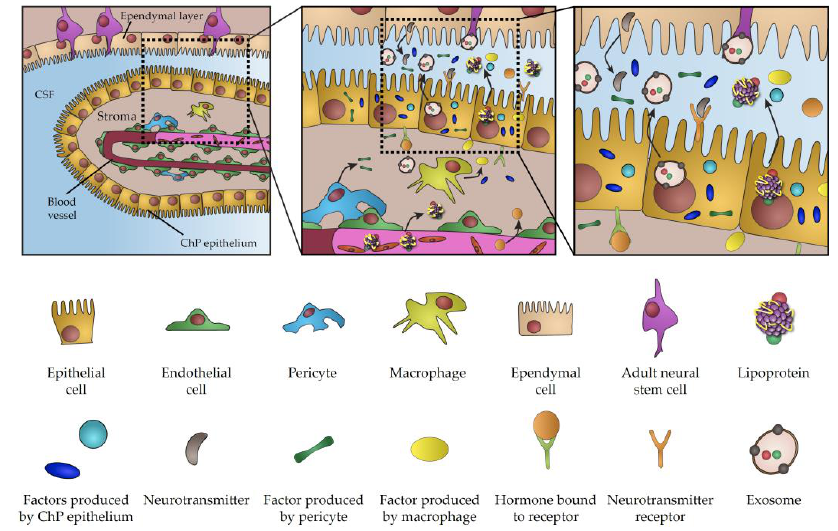
Figure 1. Schematic representation of choroid plexus secretome.